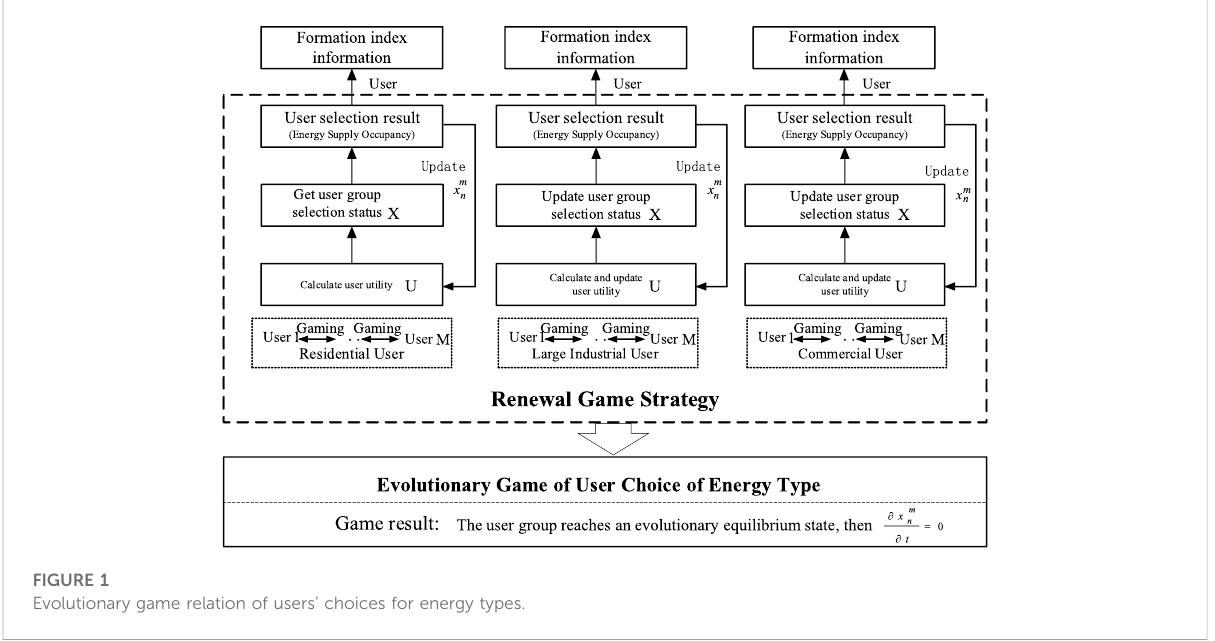
FIGURE 1 Evolutionary game relation of users ’ choices for energy